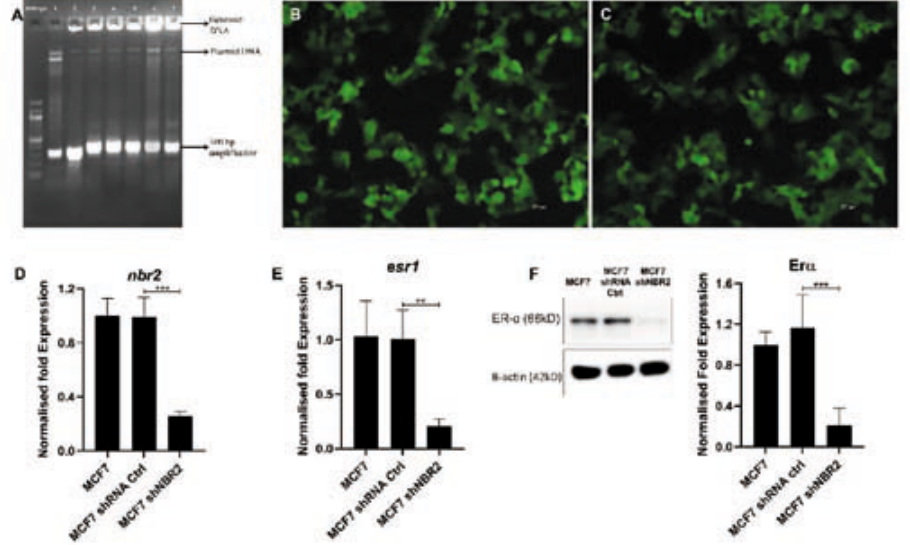
Figure. 2. a shows colony PCR image confirming the cloning of shRNA against NBR2. B & c represents the transfection of shRNA control and shRNA targeting NBR2 respectively (GFP tagged). D confirms the downregulation of NBR2 at RNA level. E & F show the ER-α expression upon NBR2 downregulation in mRNA and protein level,